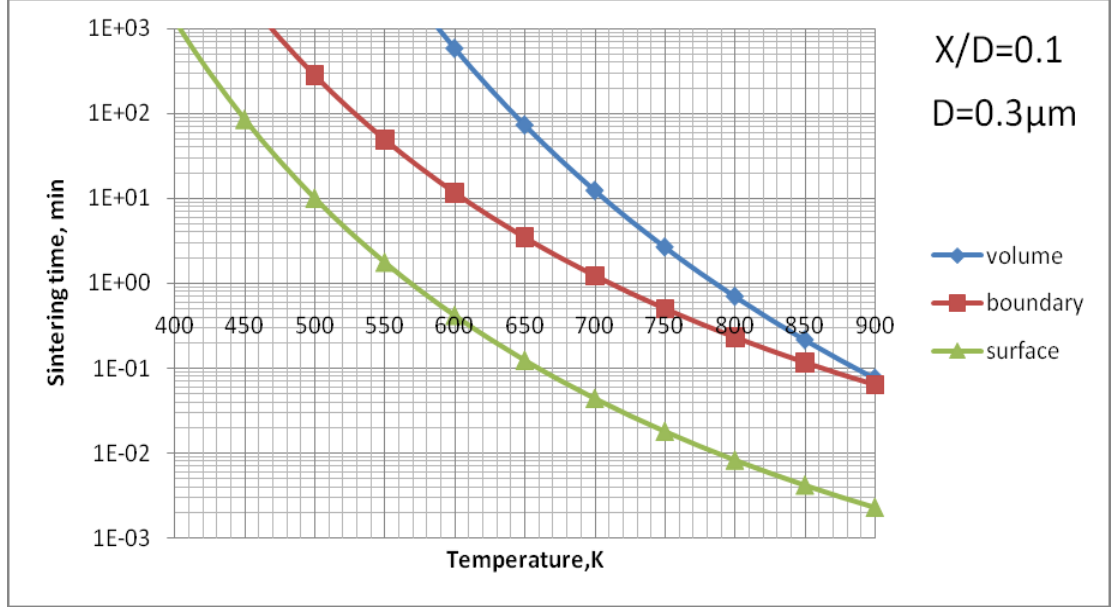
Figure 13. Sintering time of HA particles of an initial diameter of D = 0.3 µm vs. temperature for three mechanisms of mass-transport: volume, grain boundary and surface diffusion.